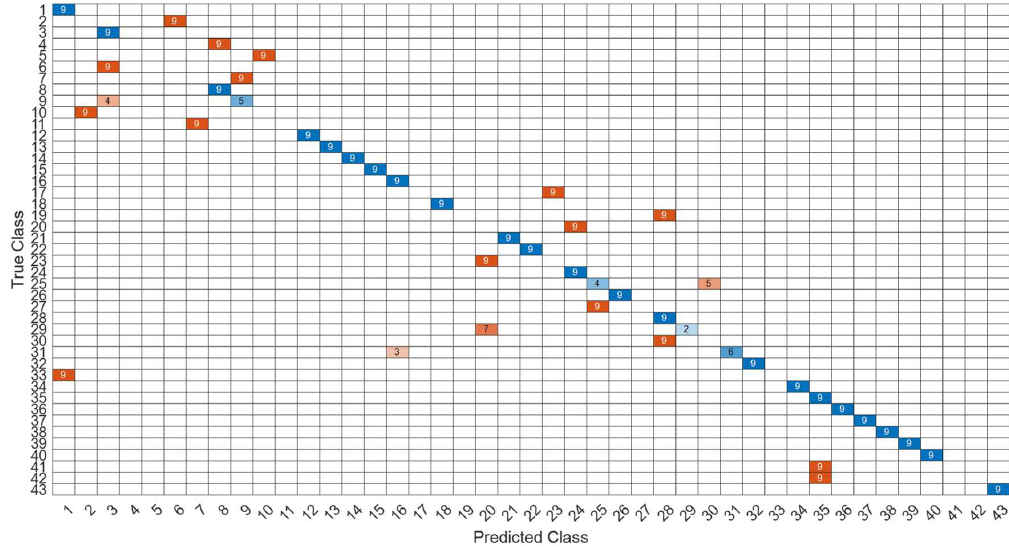
Figure 20. The confusion matrix of the DNN model with LPC 30-features dataset.